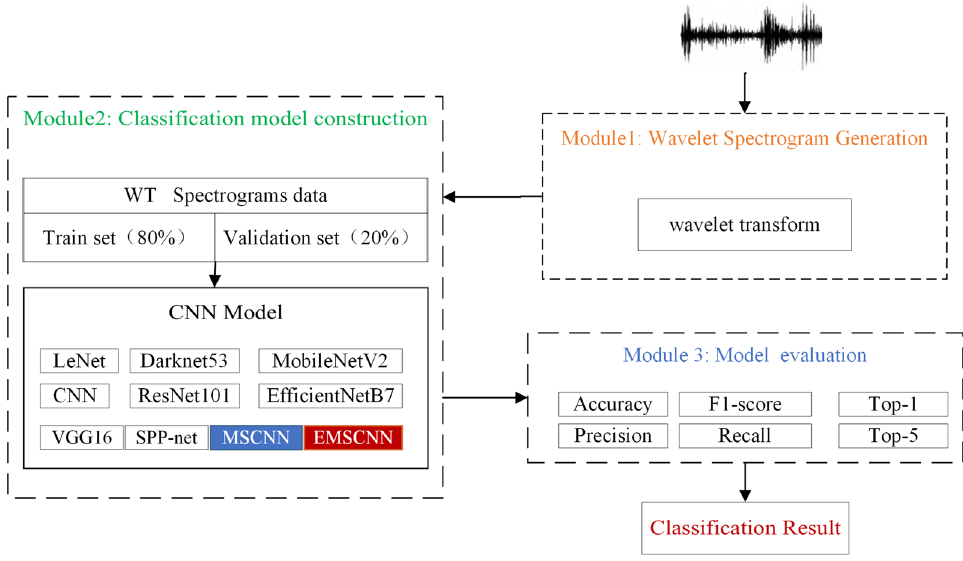
Figure 5. Experimental design